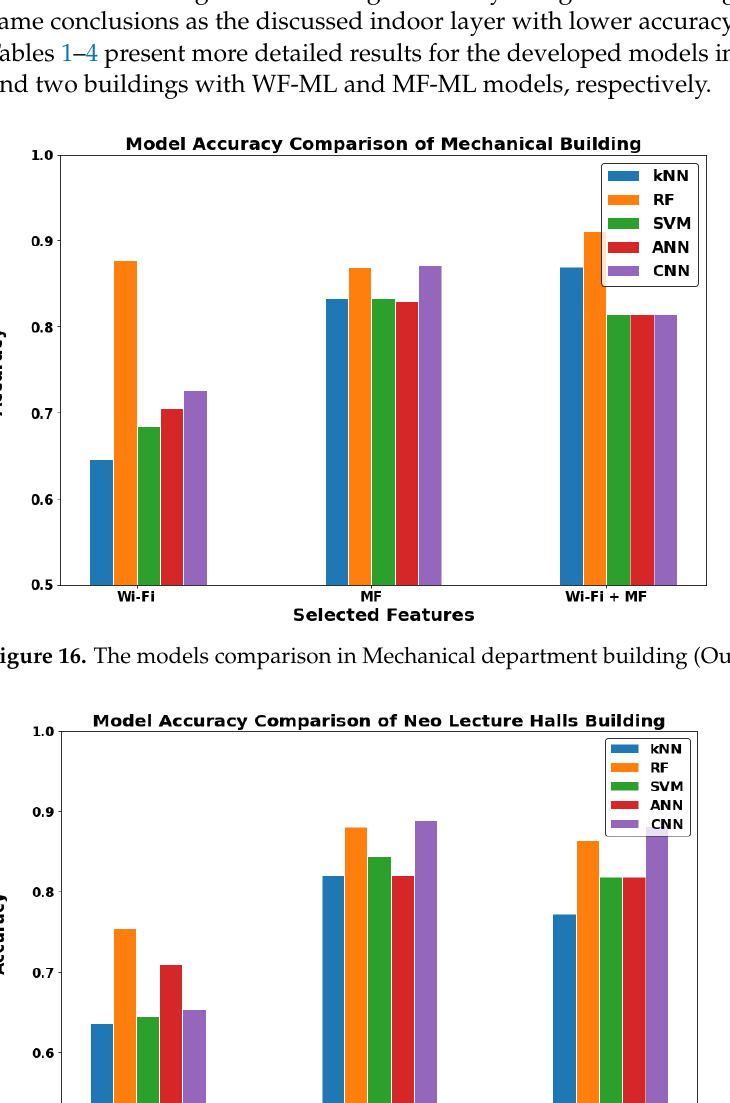
Figure 17. The models comparison in Neo Lecture Halls building (Outdoor).